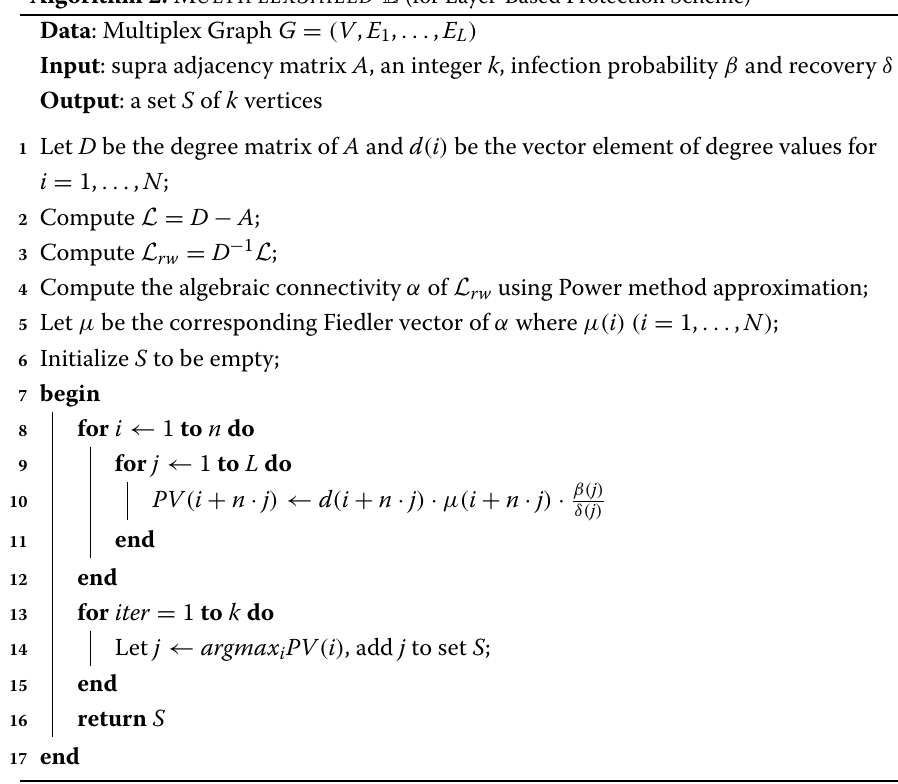
Algorithm 2: M ULTIPLEX S HIELD - L ( for Layer-Based Protection